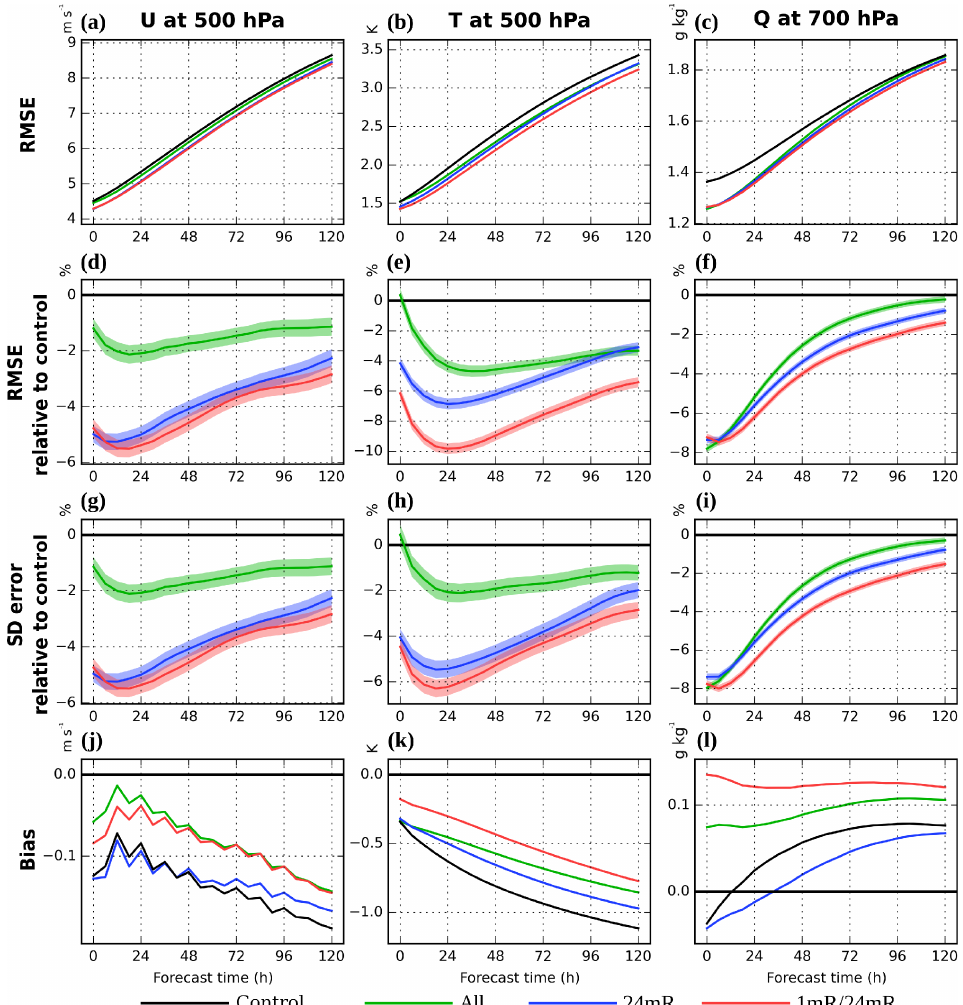
Figure 6. (a–c) RMSE, (d–f) RMSE relative to CONTROL (percent), (g–i) standard deviations of errors (i.e., random errors) relative to CONTROL (percent), and (j–l) biases during the 5-day forecasts of (a, d, g, j) 500hPa u wind, (b, e, h, k) 500hPa temperature, and (c, f, i, l) 700hPa specific humidity for the cycled OSEs. They are verified globally against the ERA-Interim reanalysis over a 1-year period. The light color shading associated with each experiment indicates the 95% significance interval compared to CONTROL based on a paired-difference t